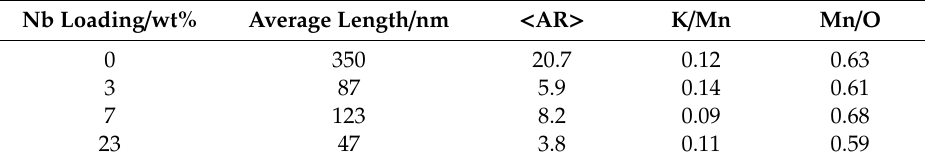
Table 2. Structural and textural parameters of Nb / K-OMS-2 derived from TEM and EDX. Nb Loading / wt% Average Length /